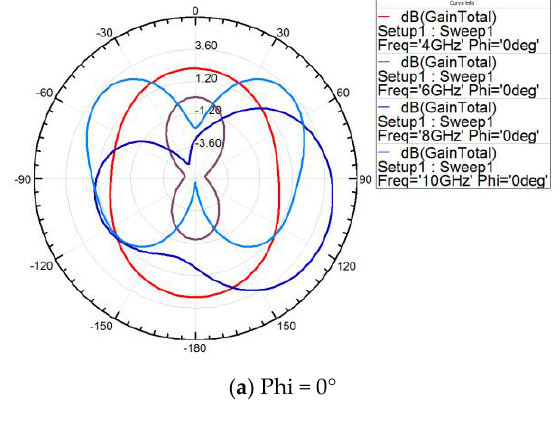
Figure 24. Simulated maximum gain for circular antenna with 3 × 3 C-SRR.